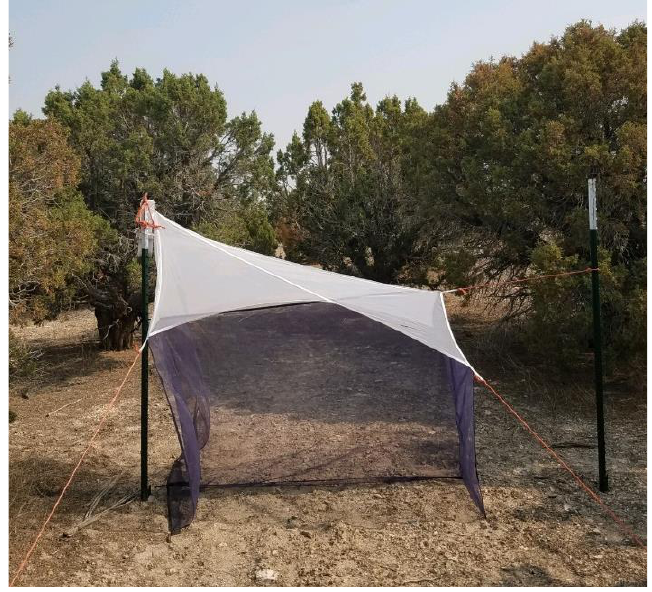
Figure 2. Malaise trap setup. Trap shown in pinyon/juniper habitat.